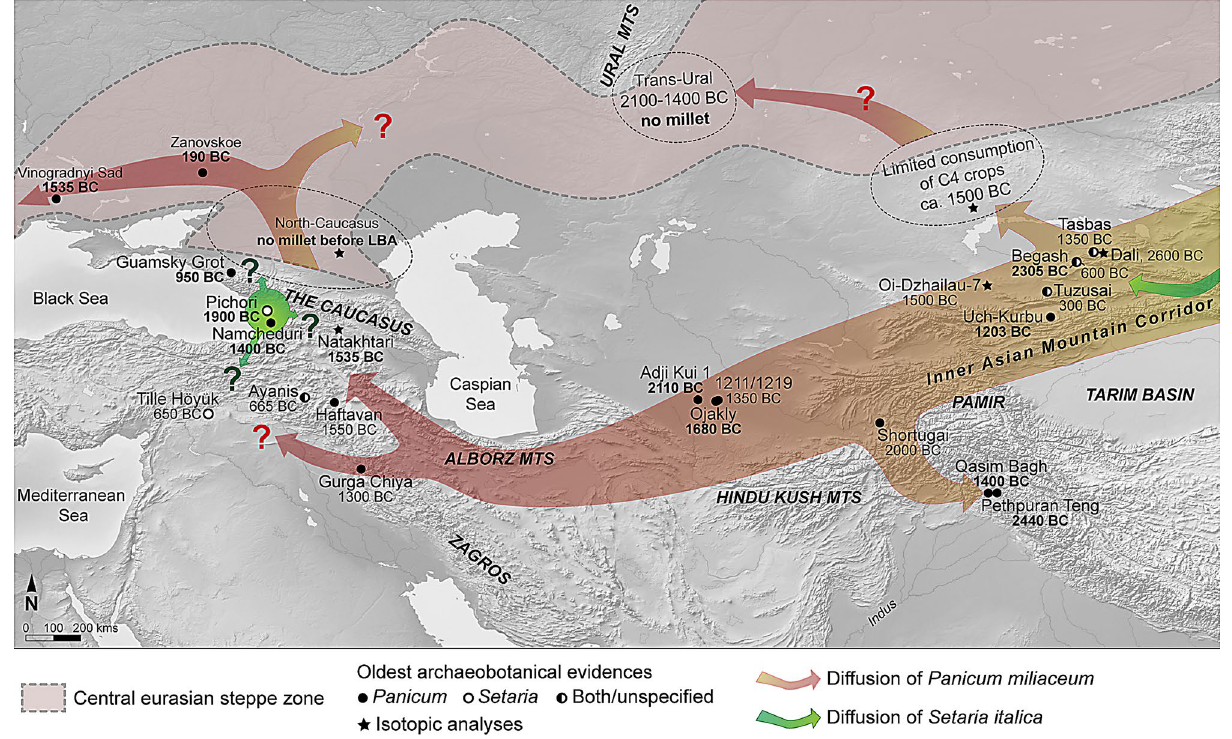
Figure 4. A schematic diffusion of millets ( Panicum miliaceum and Setaria italica ) across Eurasia and the Caucasus. Bold dates are millet grains directly dated . The dates are averages. E.g. “mid-2nd millennium” = 1500 BC. When 14C available: 2 sigma is preferred and rounded (e.g. for Tasbas, 1416–1287 cal BC = 1350 BC). BC implies cal BC. (Background map made with Natural Earth @